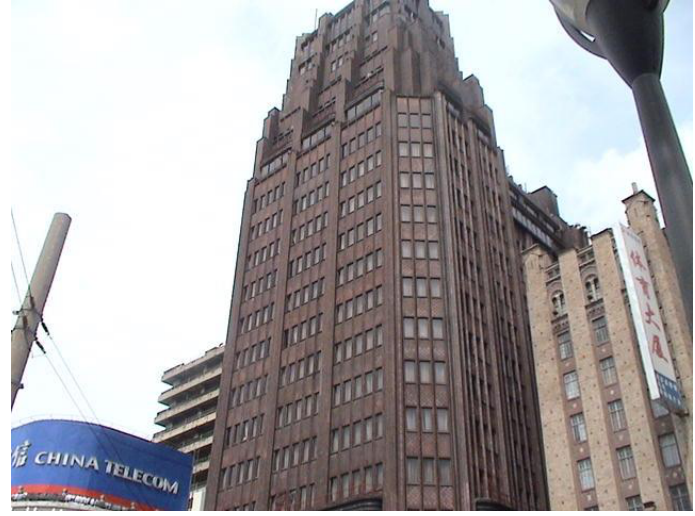
Figure 17. JSS Building (Park Hotel) — main view, detail of the façade decoration from the middle part and detail of the upper part.